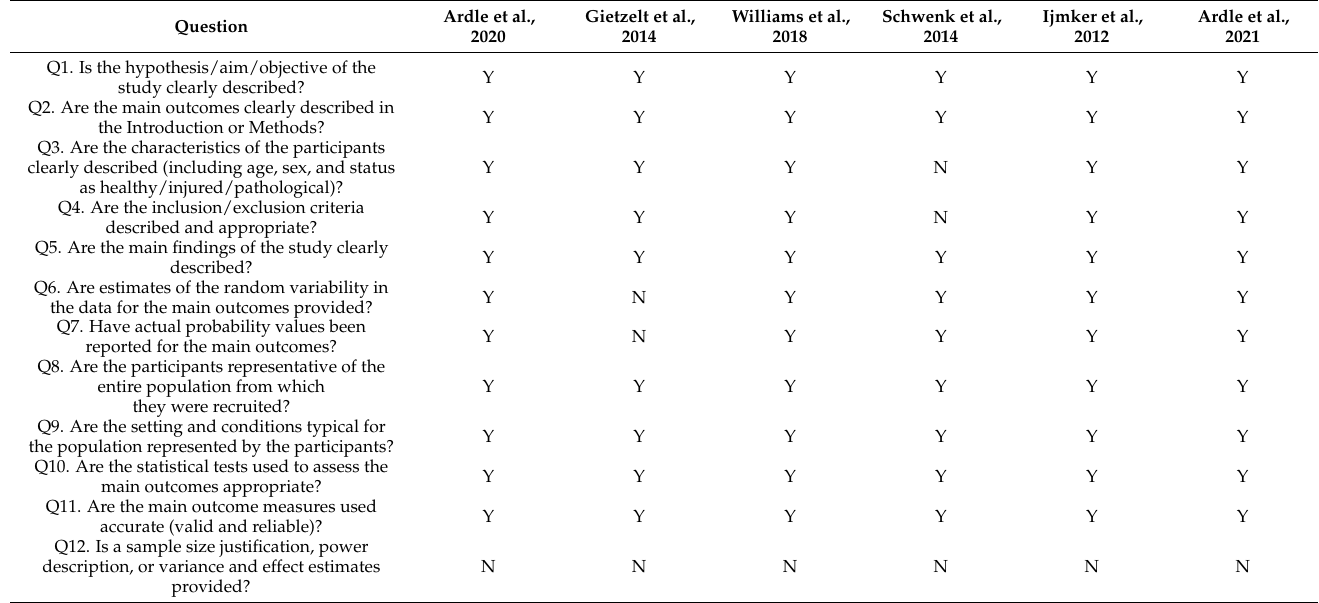
Table 3. Quality assessment